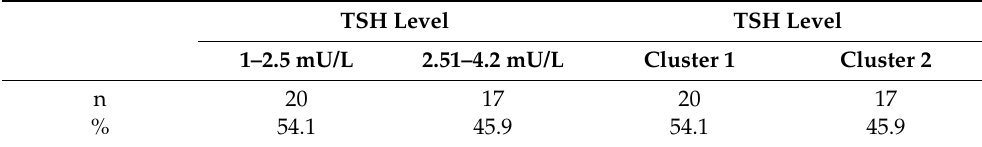
Figure 3. Relationship between the functioning of the thyroid gland and individual variables. Table 9. Descriptive statistics on the cluster